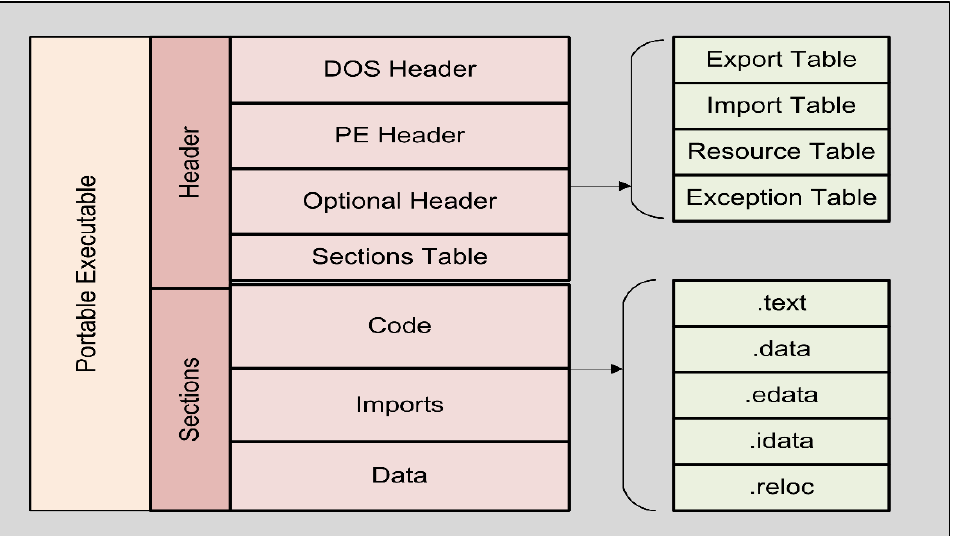
Figure 1. Portable executable (PE) file format.